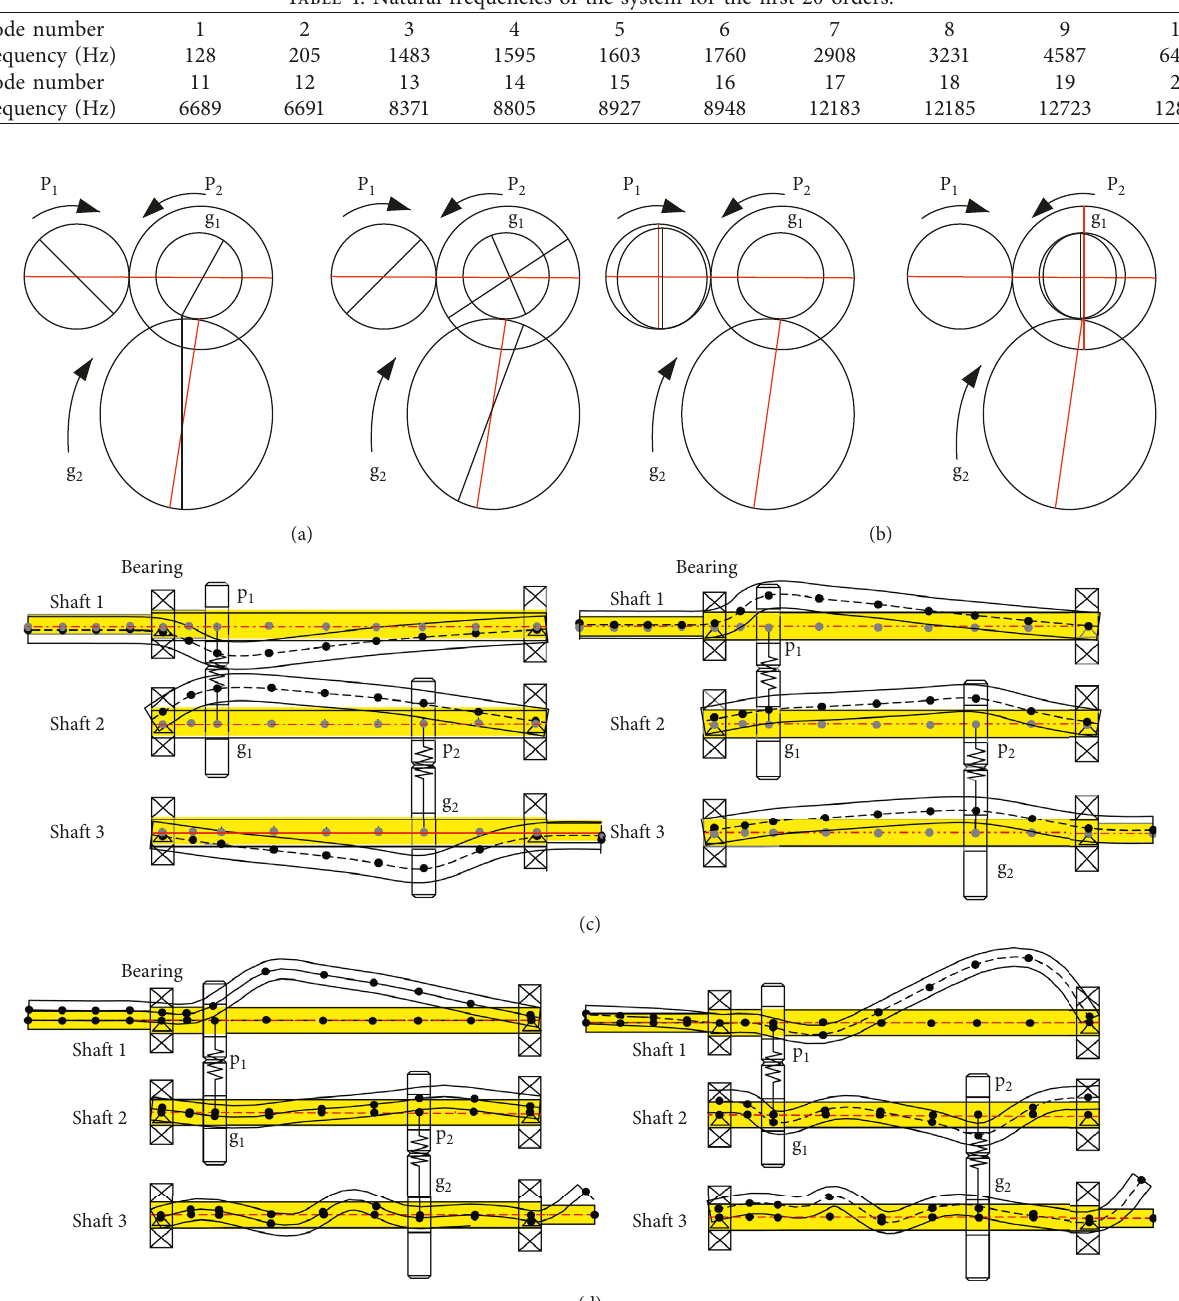
Figure 11: Mode shapes of the gear transmission system. (a) Torsional mode shapes of the coupling gear. (b) Transverse mode shapes of the coupling gear. (c) First-order bending mode shapes of the shaft. (d) Higher-order bending mode shapes of the